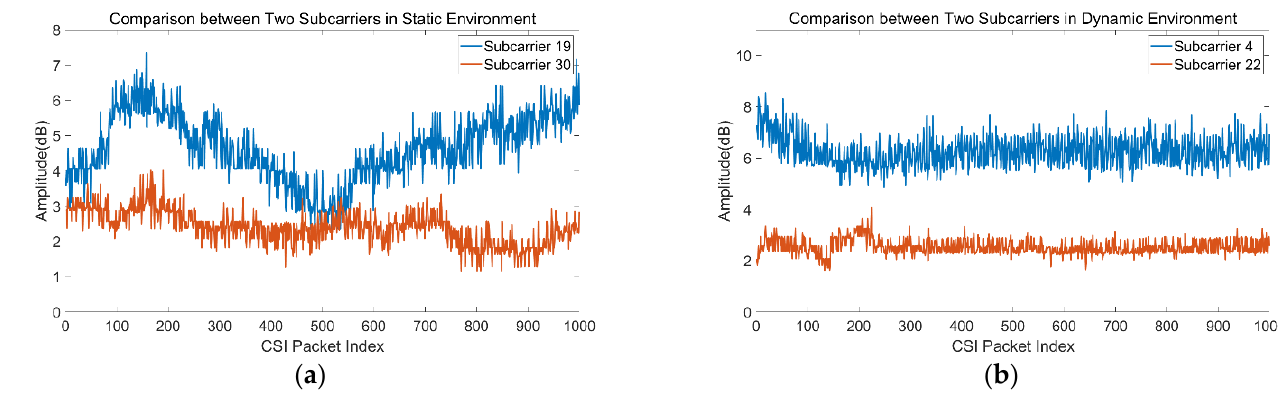
Figure 3. Examples of the fluctuation of subcarriers in static and dynamic environments. ( a ) Link 1 in static environment showing no human presence. ( b ) Link 3 in dynamic environment showing human presence.